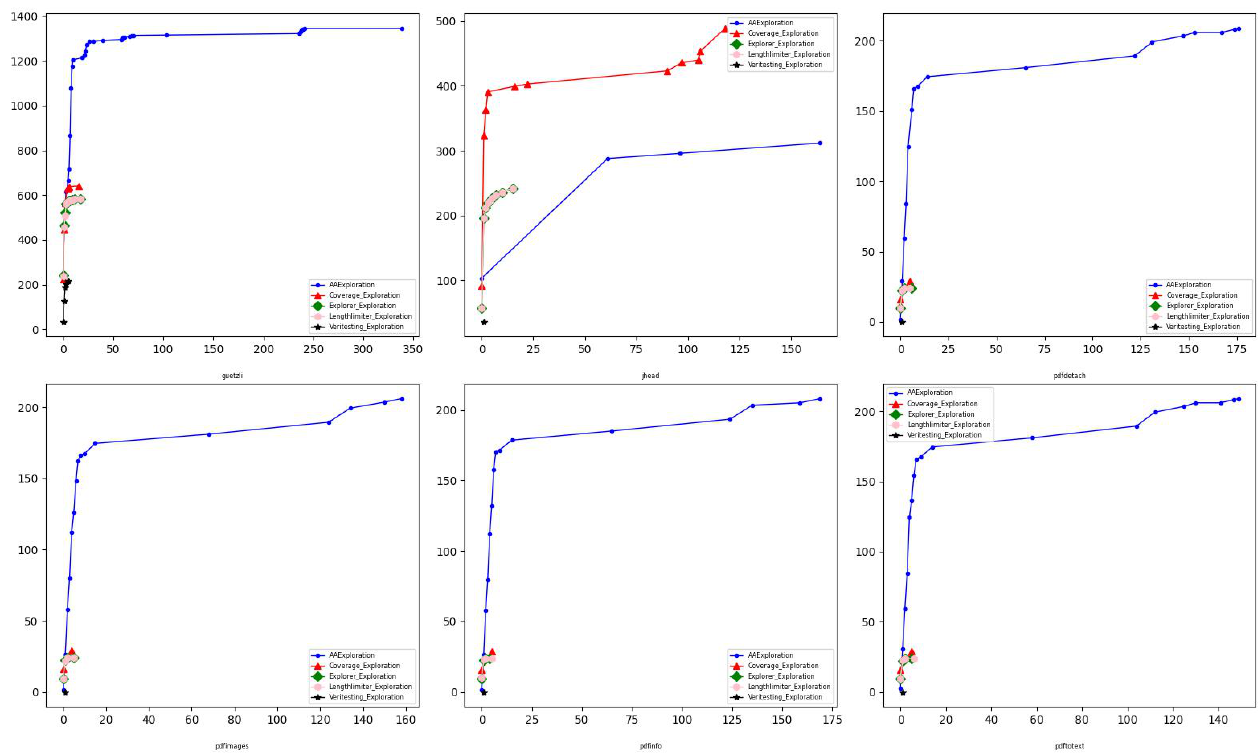
Figure 5. Improvements in path exploration capability (block coverage) when exploring programs that cause state space